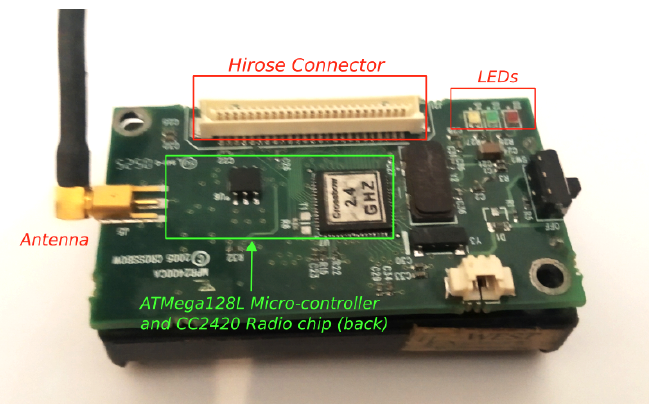
Figure 1. Example Wireless Sensor Network (WSN) mote: the MICAz.